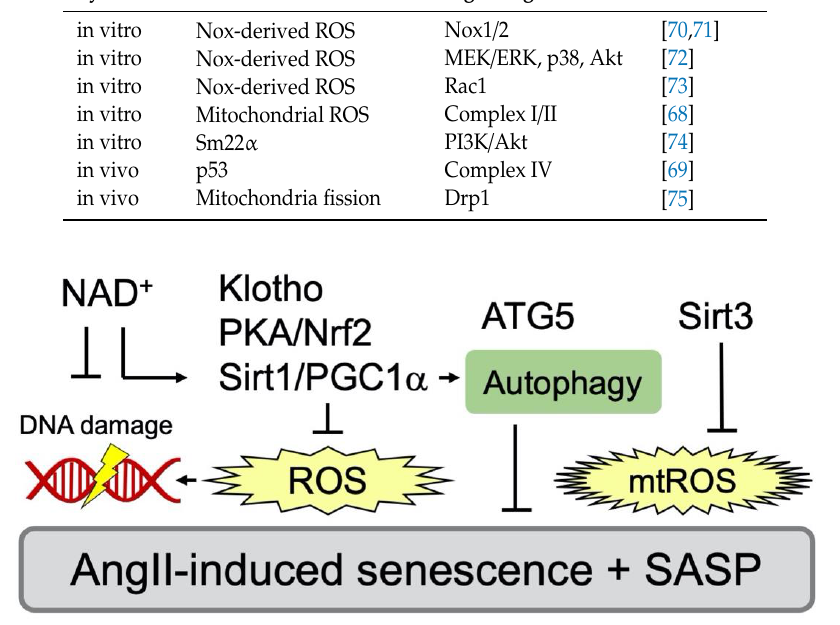
Figure 3. Inhibitory signaling events against AngII/AT 1 R-mediated senescence in VSMC. Various inhibitors